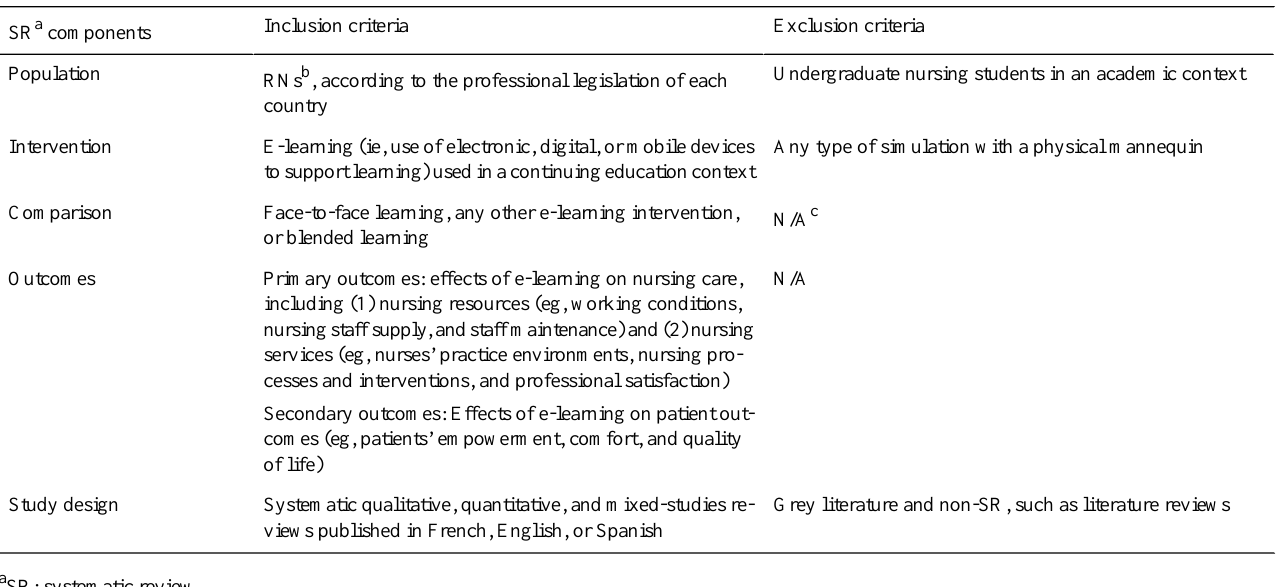
Table 1. Eligibility